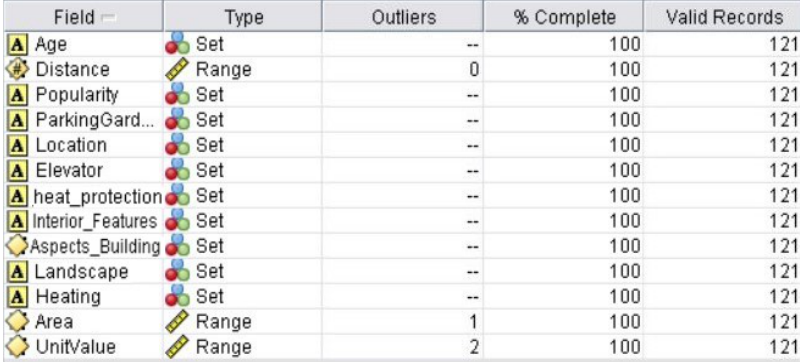
Fig. 4. Results of data quality (developed by the